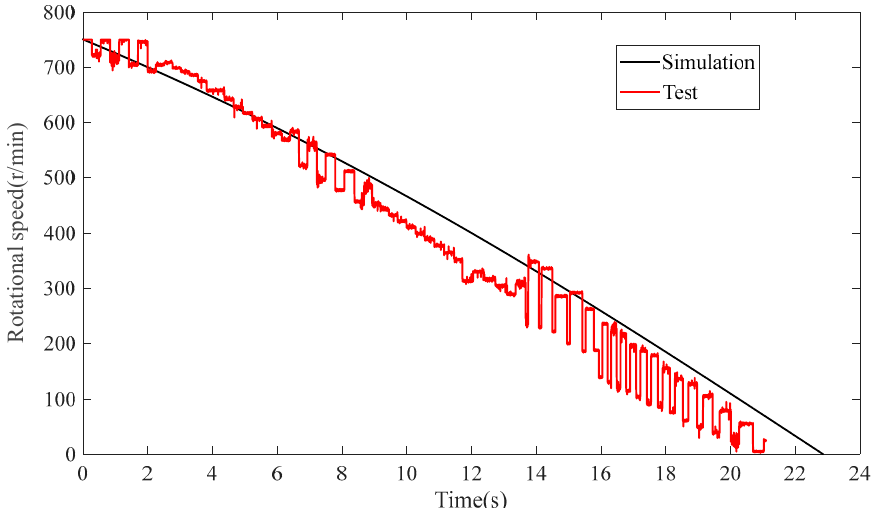
Figure 4. The variation curve of flywheel rotational speed .